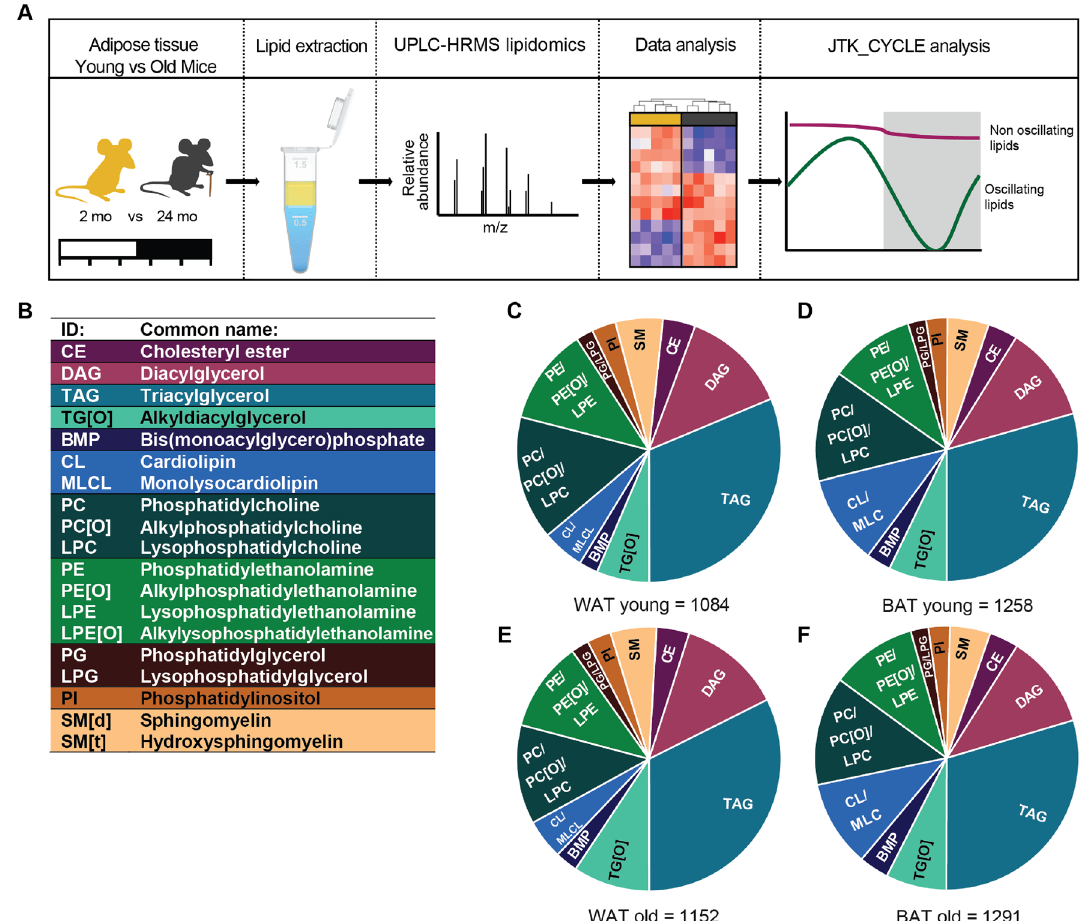
Figure 1. Lipid profiling in WAT and BAT of young and aging mice. ( A ) Experimental design: 2 and 24 months old mice were sacrificed every 4 h; WAT and BAT was harvested and lipids were extracted; lipidomics and data analysis was performed; and the obtained lipid profiles were analyzed with JTK_CYCLE analysis for detection of oscillating lipids. ( B ) The abbreviations and common names of the 19 detected lipid classes. The lipid composition of young mice in WAT ( C ), BAT ( D ), and of aged mice in WAT ( E ) and in BAT ( F ). Illustration and figure layout were prepared in Adobe Illustrator CS6 (v16.0.3; https ://www.adobe .com/nl/). Pie charts were created in Graphpad Prism (v8.3.0; https ://www.graph pad.com/scien tific -softw are/prism